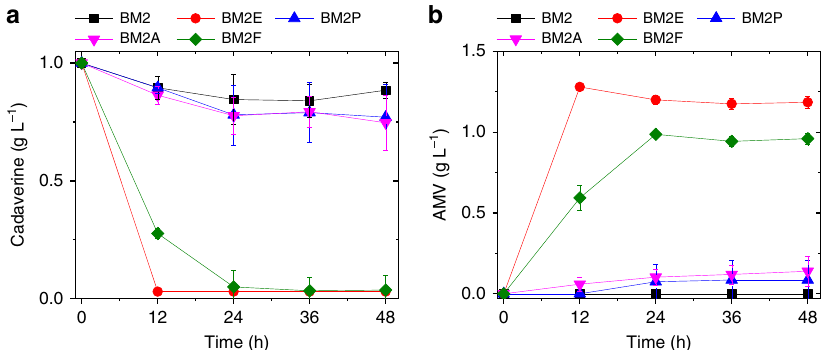
Fig. 4 Comparison of the ef fi ciency of four candidate cadaverine transporters. a Cadaverine consumption with time; b AMV accumulation with time. Data shown are mean ± SD ( n = 3 independent experiments). Source data are provided as a Source Data fi le